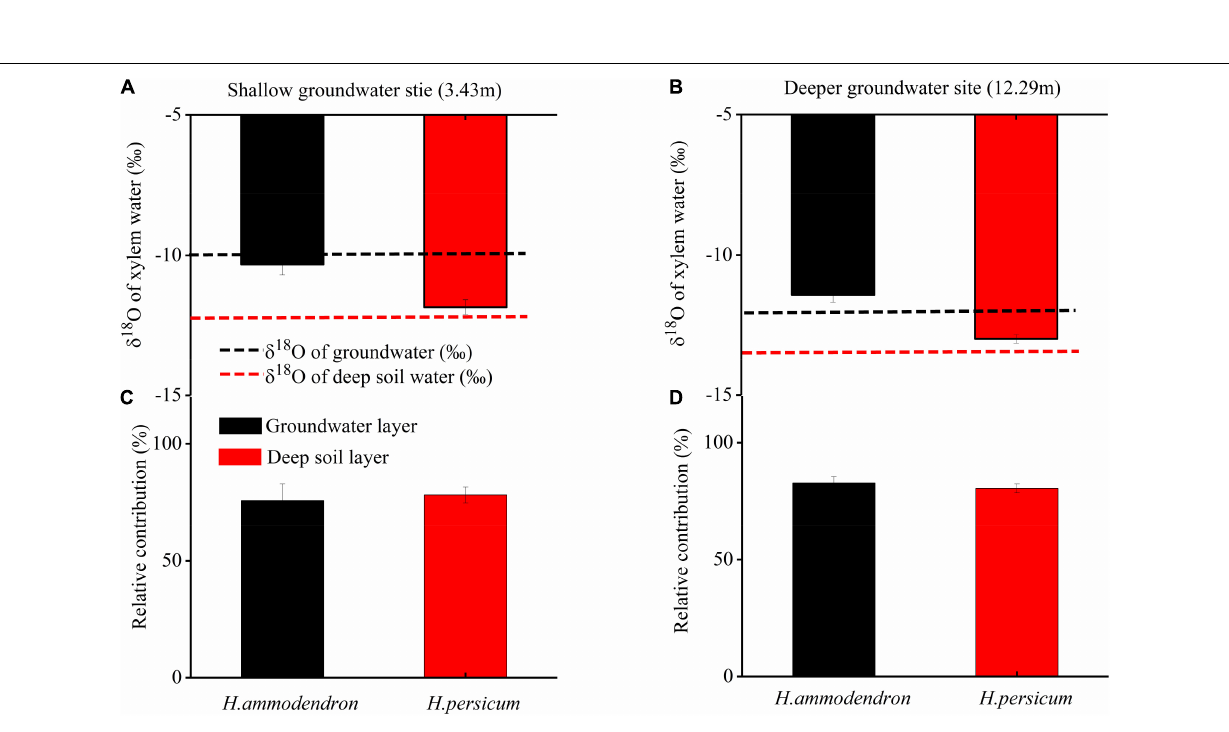
Frontiers in Plant Science |